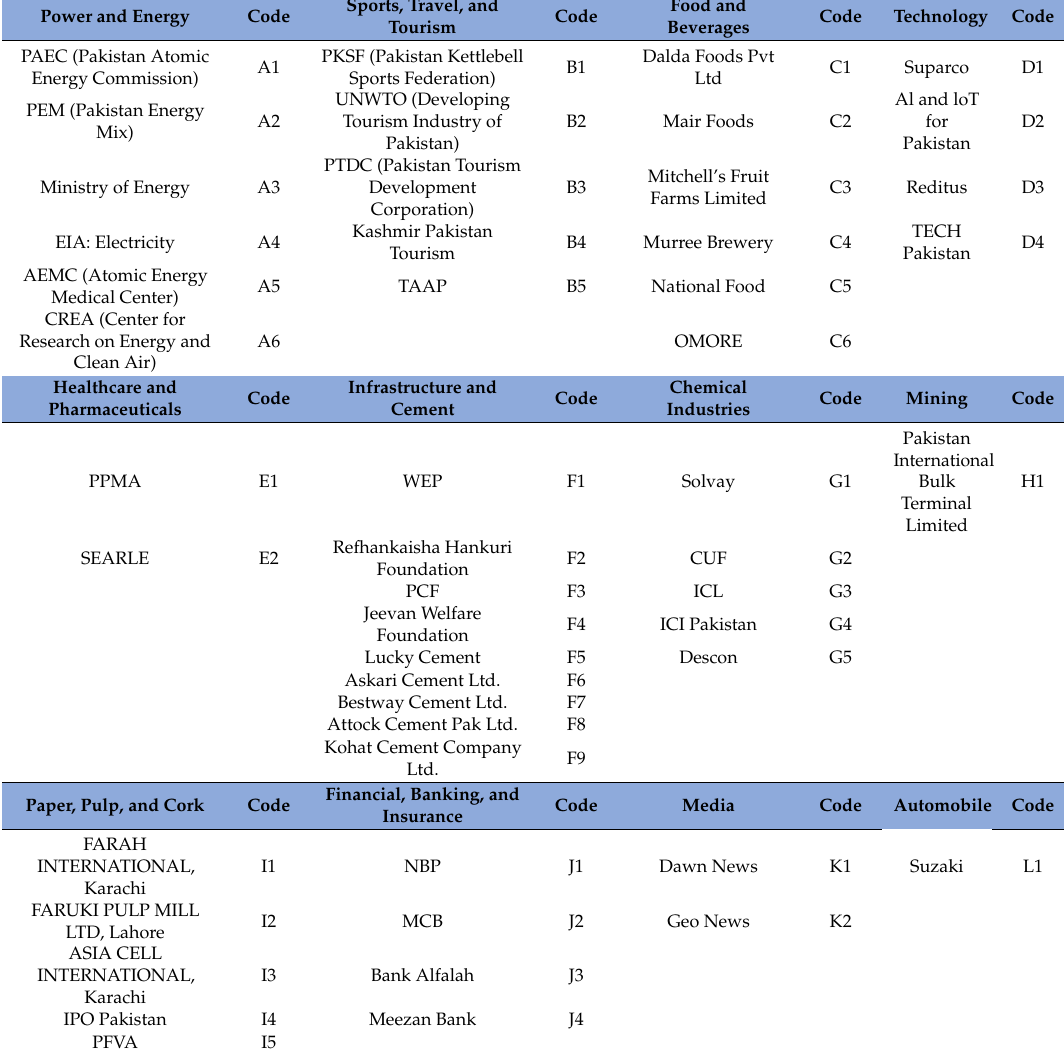
Table A1. Industries demographics and